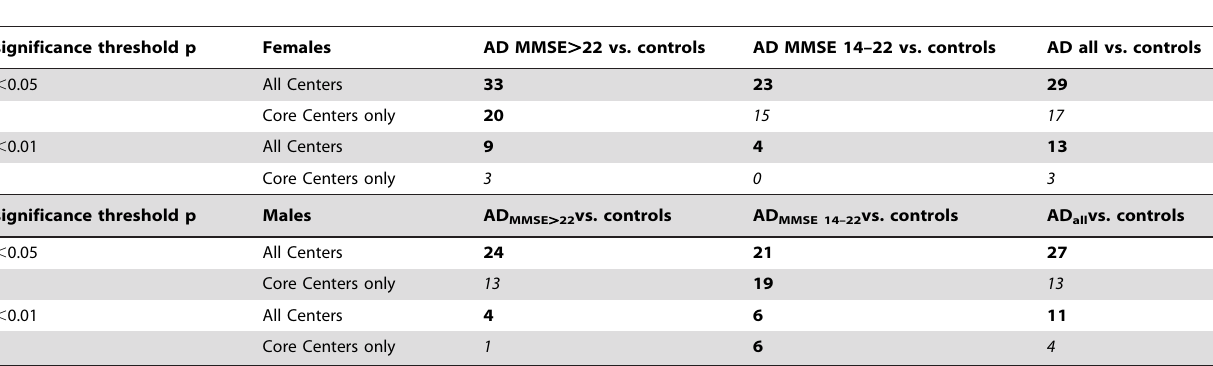
Table 2. Number of semi-quantitative analytes significantly altered in patients diagnosed with Alzheimer’s disease obtained from t-test analysis in dependency of gender and significance threshold p (in grey: number of significant changes equal or below expected false-positive rate).